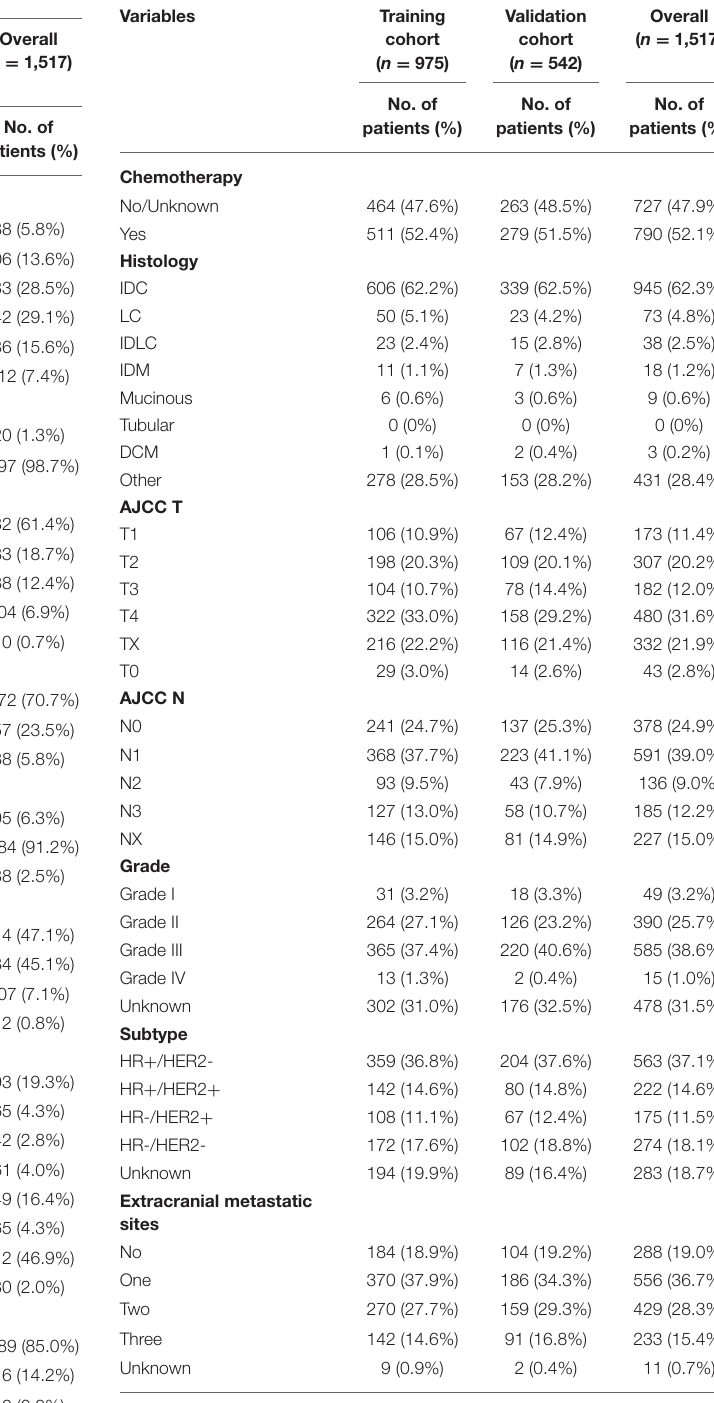
TABLE 1 | Demographics and clinicopathologic characteristics of breast cancer patients with brain metastasis.